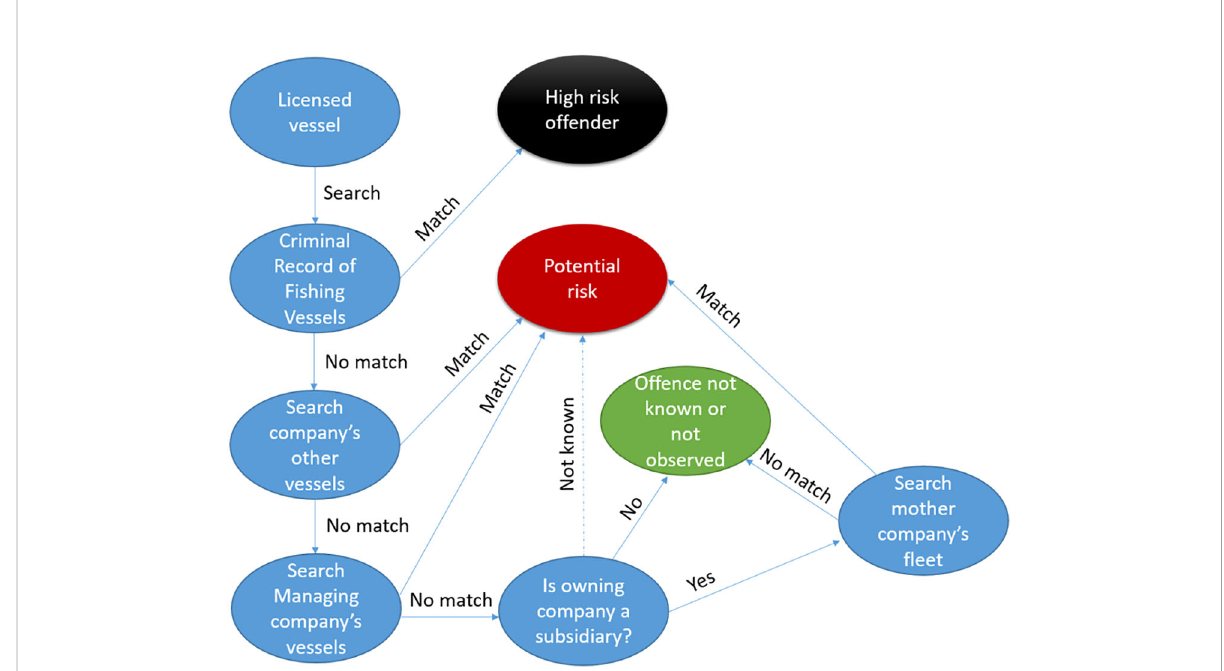
FIGURE 1 Process of identifying high-risk offenders, and potential high risk vessels by matching of fi cially registered and licensed vessels. Information from government license lists and